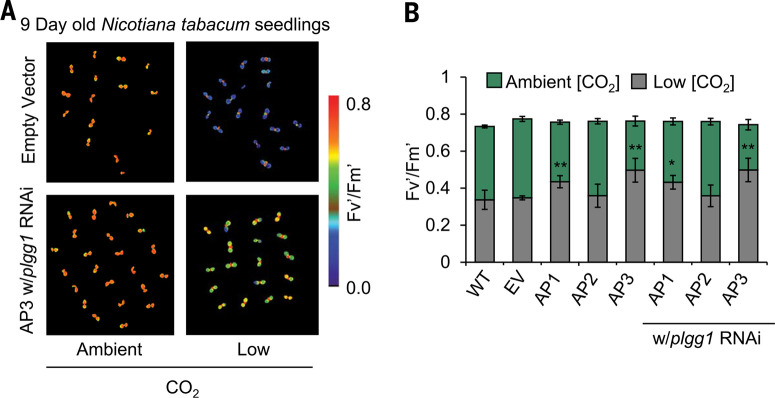
AP plant lines are more photoprotective under photorespiration stress. (A) Representative photos of 9-day-old T2 transgenic tobacco lines during the chlorophyll fluorescence photoprotection screen for AP pathway function showing AP3 protecting photosystem II from photodamage under severe photorespiratory conditions. (B) Combined values of the three AP construct designs with and without RNAi targeting the glycolate-glycerate transporter PLGG1. Error bars indicate SEM. * indicates statistical difference compared to WT based on one-way ANOVA at P < 0.05, ** P < 0.001. Fv'/Fm' for individual lines is described in supplementary data set 1. Actual significant P values are shown in supplementary data set 15.